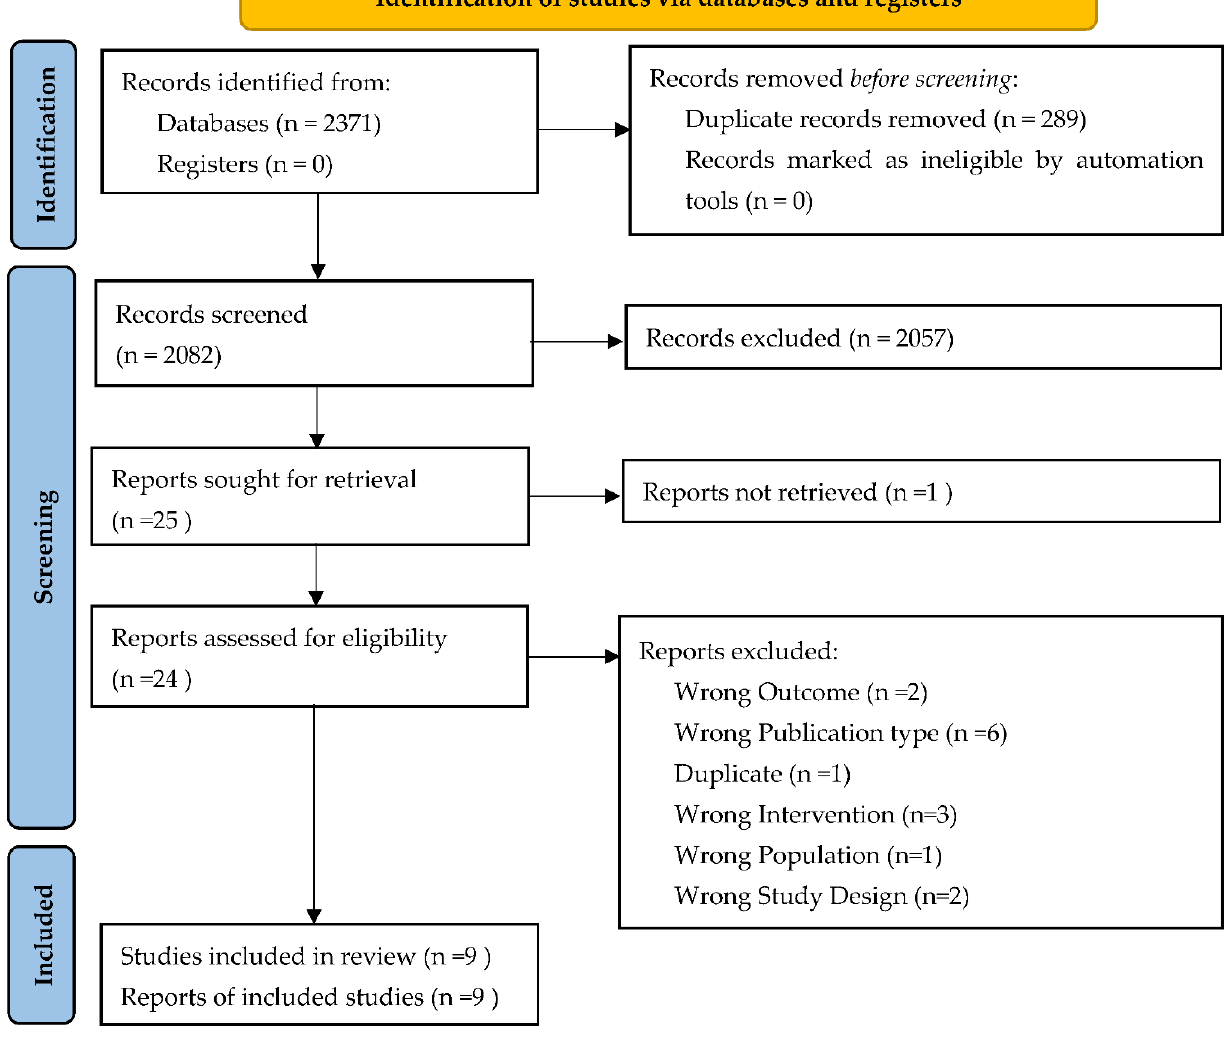
Figure 1. Flow diagram based on PRISMA statement.